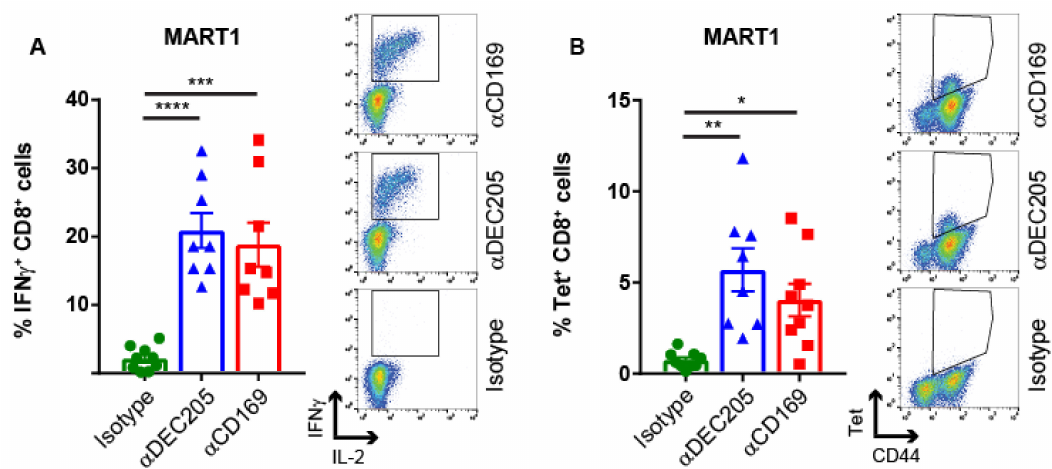
Figure 2. Targeting HLA-A2.1 restricted Ag to CD169 results in Ag-specific T cell responses in HLA A2.1 transgenic mice. Intravenous immunization with 1 µ g Ab:Ag conjugates in the presence of 25 µ g anti-CD40 Ab and 25 µ g Poly(I:C). ( A ) Percentage of IFN γ producing CD8 + T cells after 5 h in